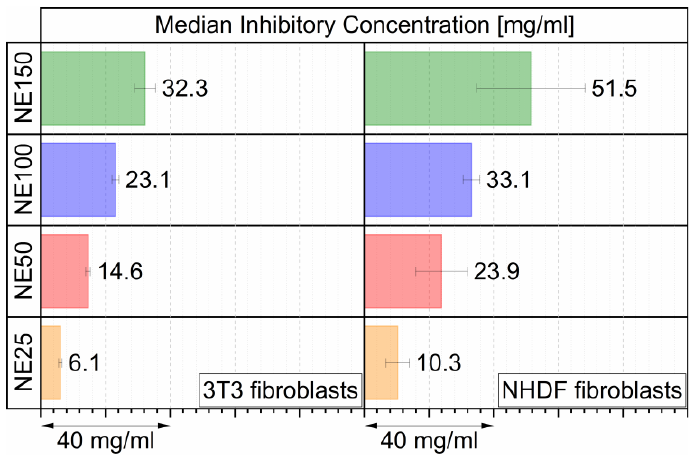
Figure 3. IC50 as total mass nanoemulsion (DiR loaded MCT, Kolliphor ® HS 15 + aqueous phase) per ml cell culture media on 3T3 and NHDF fibroblasts after 24 h of incubation, determined by three individual incubated batches (eight replicates per run).